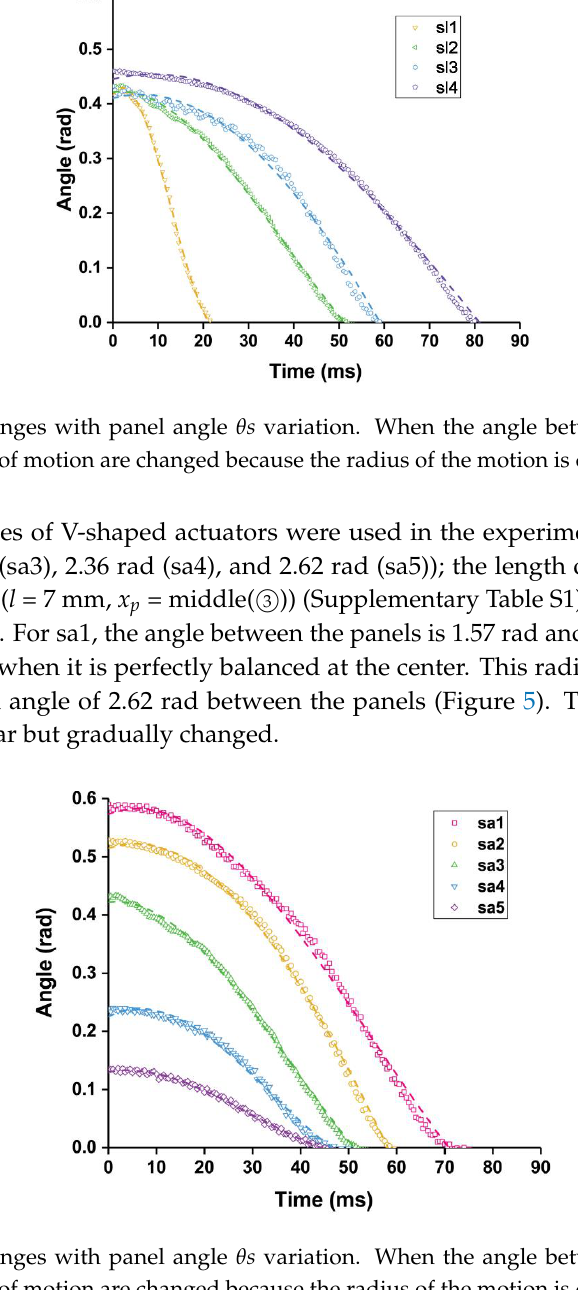
Figure 5. Angle changes with panel angle θs variation. When the angle between the two